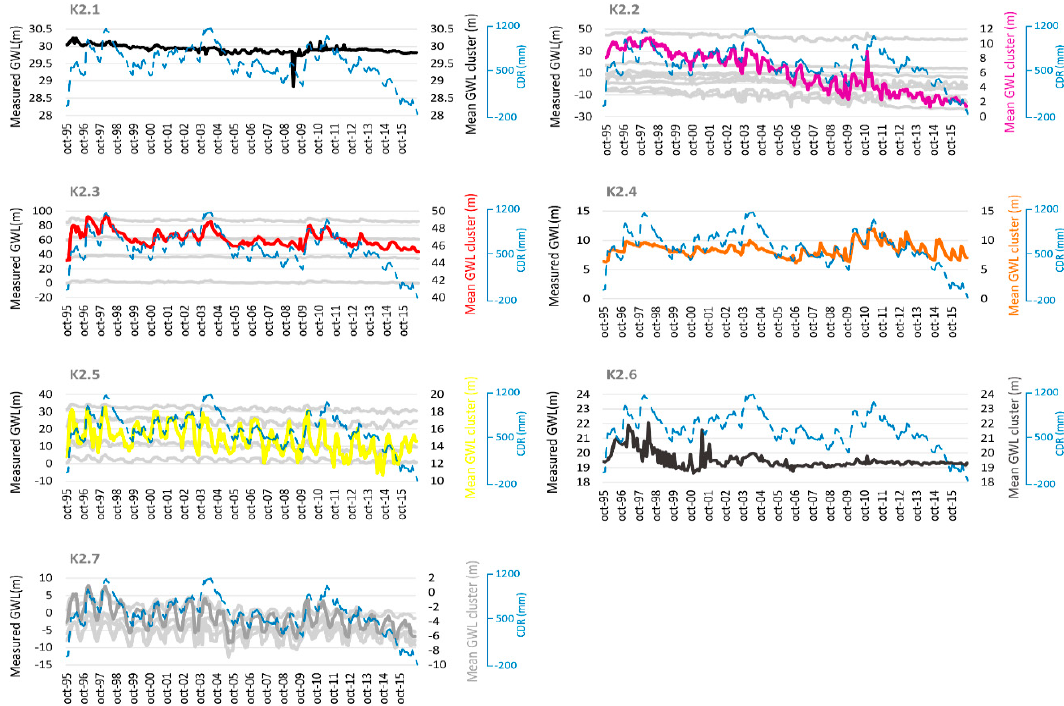
Figure 8. GWL series (grey lines), mean of the GWL cluster series (colored line) from October 1995 to September 2016 (second sub-period), classified by k-means clustering and cumulative deviation from the mean monthly rainfall (CDR).